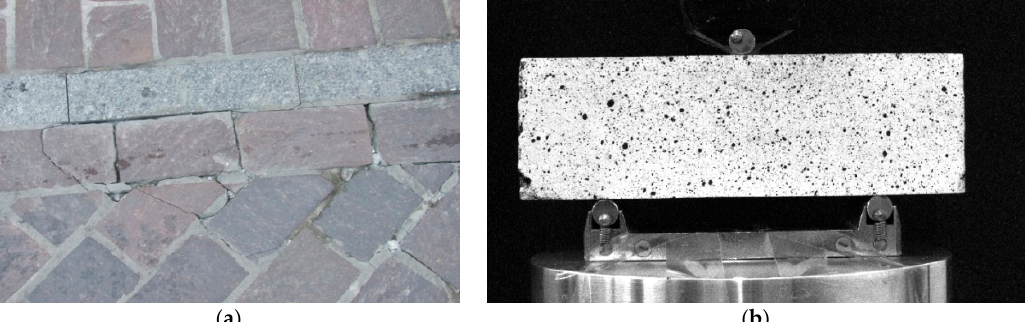
Figure 16. Stone (porphyry) sample: ( a ) Stone slab in the road pavement cracking due to bending; ( b ) stone beam prepared for a three-point bending test using DIC [25].